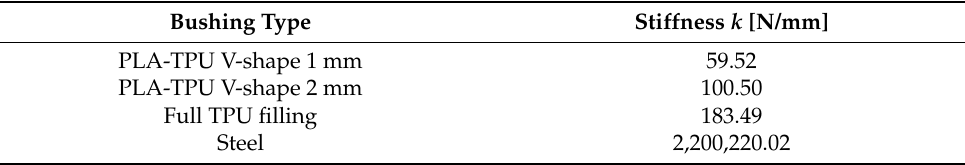
Figure 6. Deformation of the PLA-TPU bushing with 2 mm thick V-shaped filling at 200 N force. Based on the deformation values obtained in the FEM analysis, the stiffness values were calculated and presented in Table 6. Table 6. Stiffness k values of each series at 200